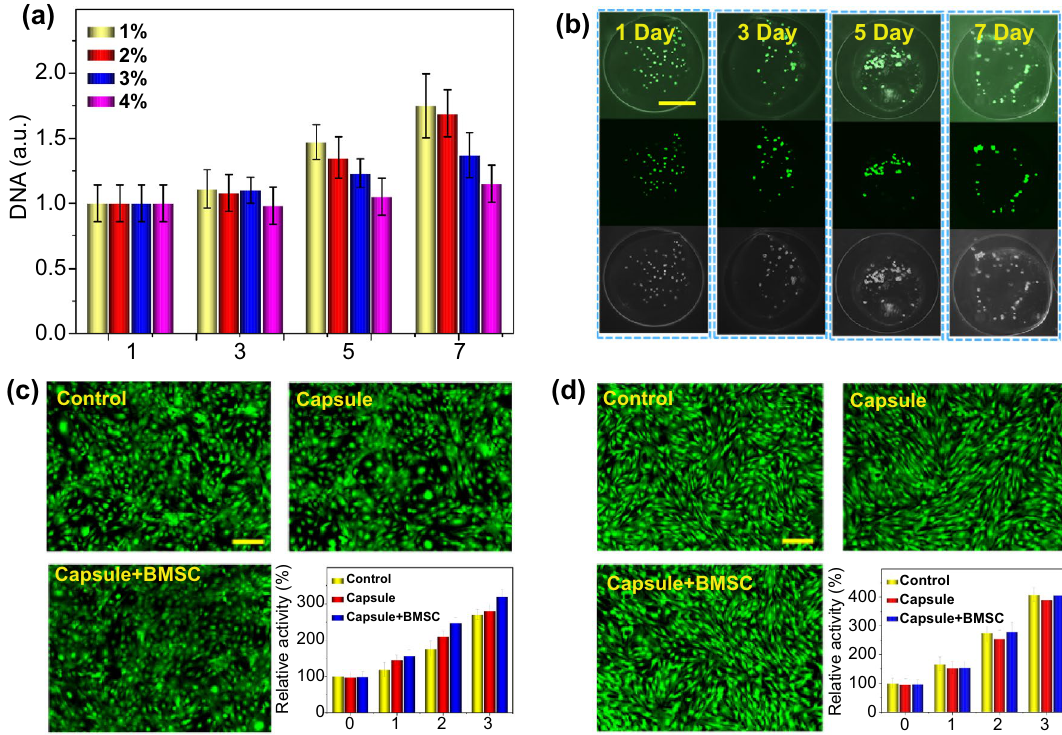
Fig. 4 Cell proliferation and biocompatibility test in vitro . a The cell proliferation in different concentrations of biomass microcapsules. b The morphological changes of cells after 1–7 days culture in microcapsules, respectively. c Biocompatibility test when co-cultured with MC3T3-E1 after 3 days. d Biocompatibility test when co-cultured with BMSC after 3 days. Scale bar in ( b ) is 100 μm and in ( c and d ) is 50